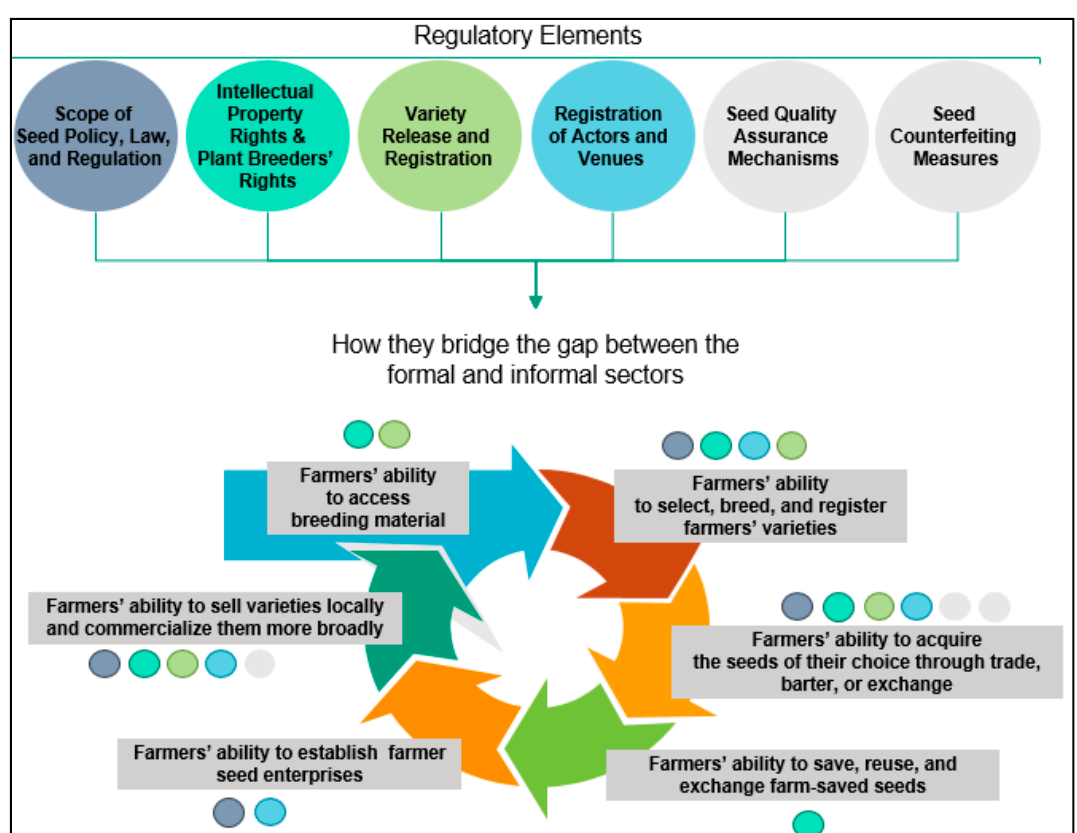
Figure 3. Regulatory elements of extending market frontiers (adapted from